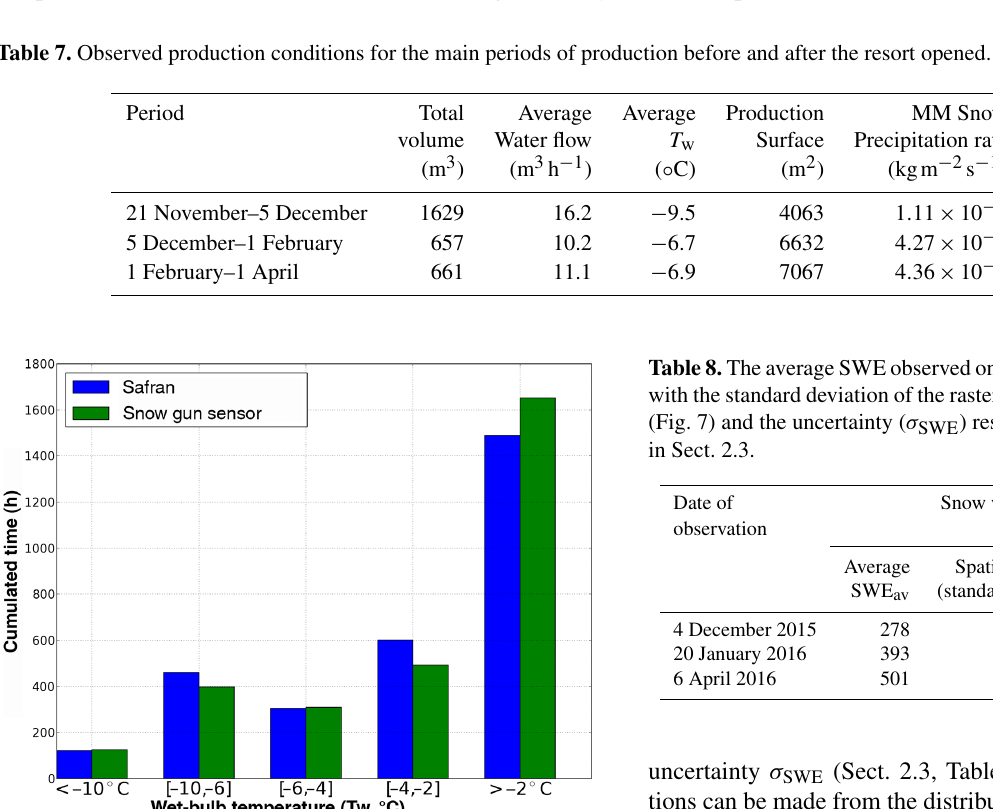
Figure 6. Cumulated time-span over which wet-bulb temperature fell within specific ranges, from the in situ data (snowgun sensor) and SAFRAN (20 November 2015–15 March 2016).